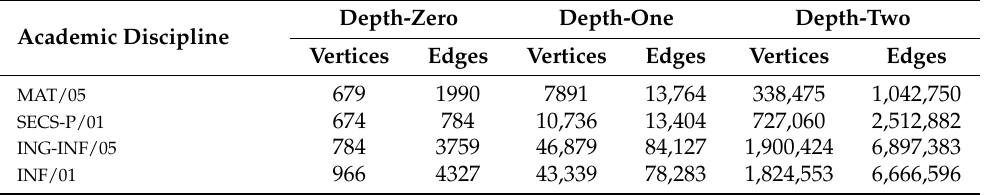
Table 2. Italian co-authorship networks size of the academic disciplines under analysis.